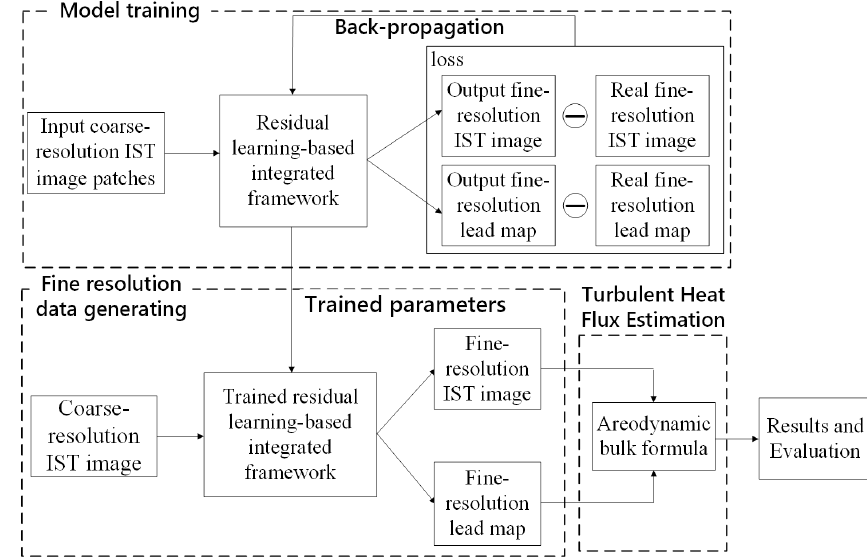
Figure 4. The flowchart of the subpixel-scale THF estimation using the proposed deep residual convolutional neural-network-based frame- work. Note that IST denotes the ice surface